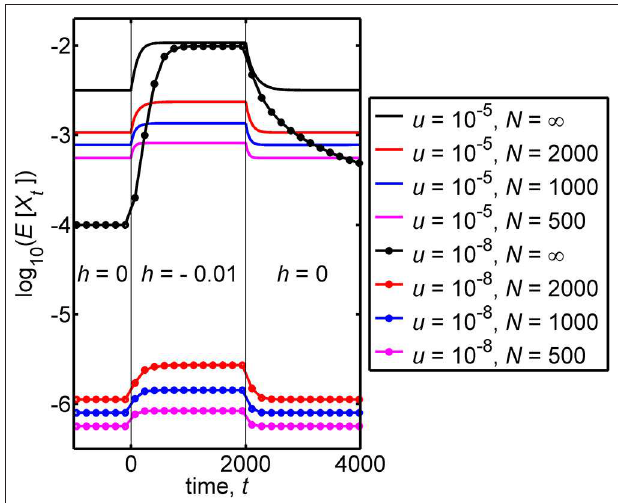
FIGURE 3 | This figure contains plots of the logarithm of the mean frequency E [ X t ] of the disease-causing allele, log 10 , against the time, t . For a large (cid:0) (cid:1) (effectively infinite) population, there are negligible deviations of the frequency from its expected value and E [ X t ] then coincides with the frequency itself, X t . The infinite population results are given by the black curves. Finite population results are given by colored curves. The figure illustrates transient behavior that Figure 3 . For intermediate times the half time to equilibrium the frequency can exhibit in populations with different mutation rates, u , and different population sizes, N when the following are assumed. (i) For a very long time prior to t 0 the relative fitness of the heterozygote has the value 1 = (corresponding to a dominance coefficient of 0). (ii) At time t 0 the relative = fitness of the heterozygote discontinuously jumps to the value 1.01 (corresponding to a discontinuous jump in the dominance coefficient from 0 to 0.01). (iii) At time t 2,000, the relative fitness of the heterozygote − = discontinuously jumps back to the value 1 (corresponding, again to a dominance coefficient of 0). The figure was obtained using Equation (4), for an effectively infinite population, and from the Wright-Fisher model describing a lethal genotype, based on Equation (7). We note that where the curves become flat closely corresponds to the attainment of equilibrium, and values of equilibrium frequencies can be found in Table 1 . Additionally, the time to approach equilibrium depends on the pre- and post-jump values of h , and each curve takes different times to approach equilibrium. A measure of such times to equilibrium is given in Table 2 . The black dotted curve, which applies for u 10 − 8 and N , is the only curve that does not come close to = = ∞ equilibrium at long times. The equilibrium value, that this curve eventually attains, coincides with the value that the curve takes prior to t 0. =